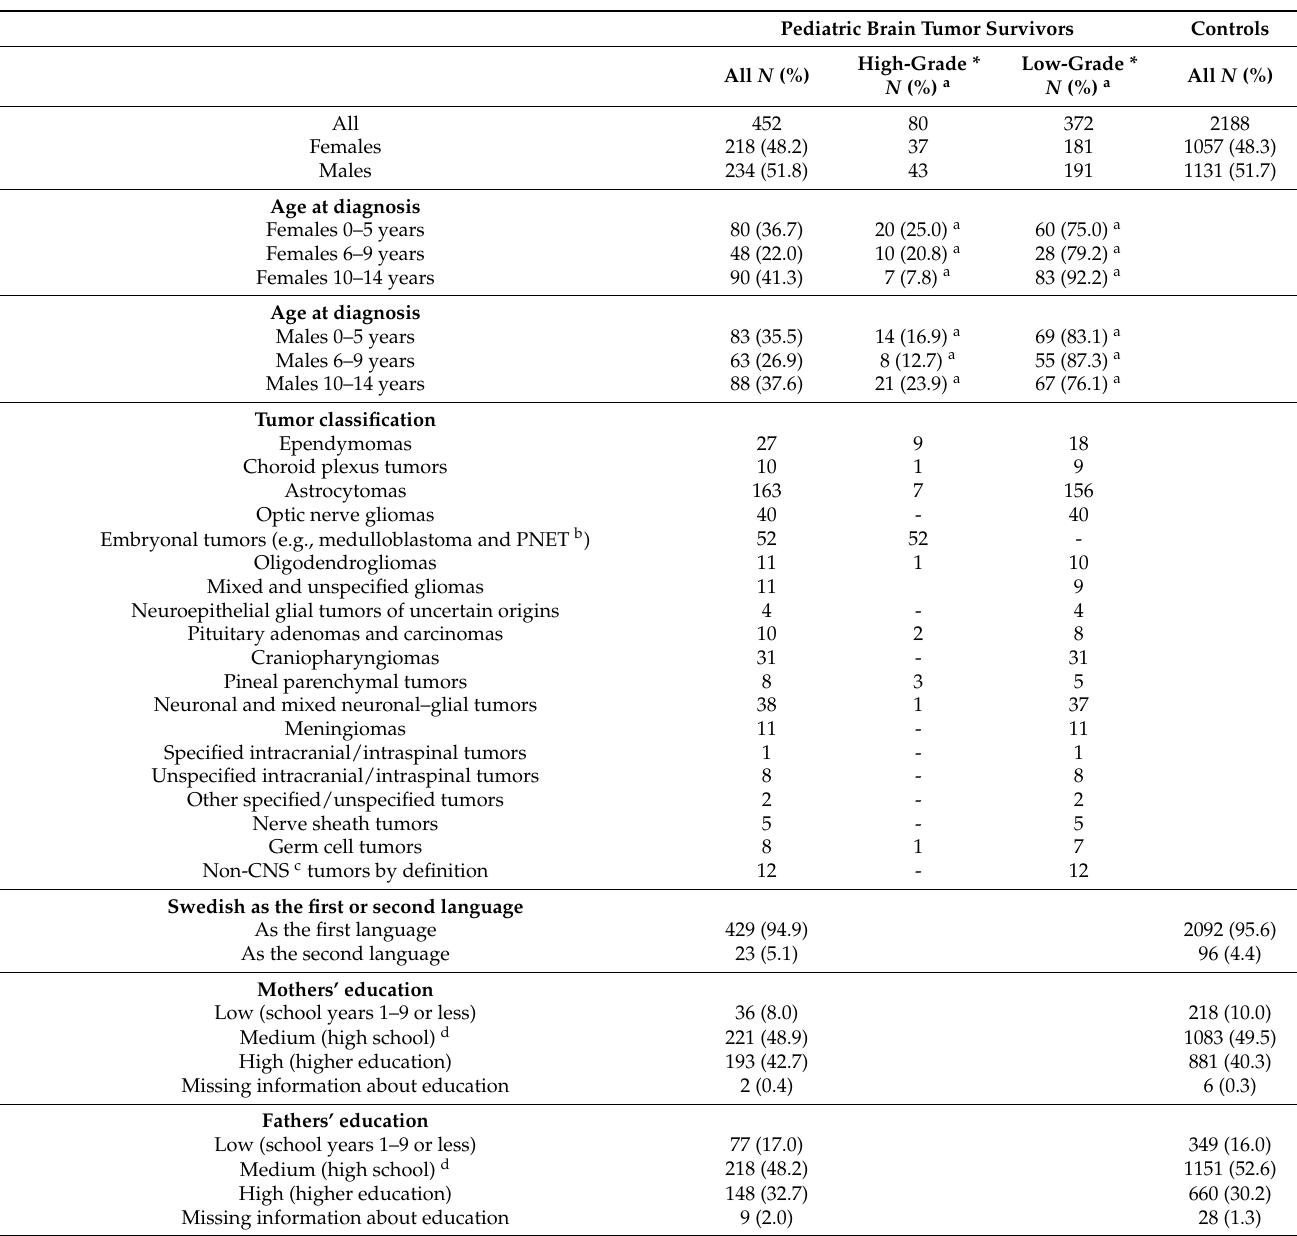
Table 1. Included pediatric brain tumor survivors ( n = 452) and controls (n = 2188) and population characteristics describing age at diagnosis, tumor classification, Swedish as first or second language, and parents’